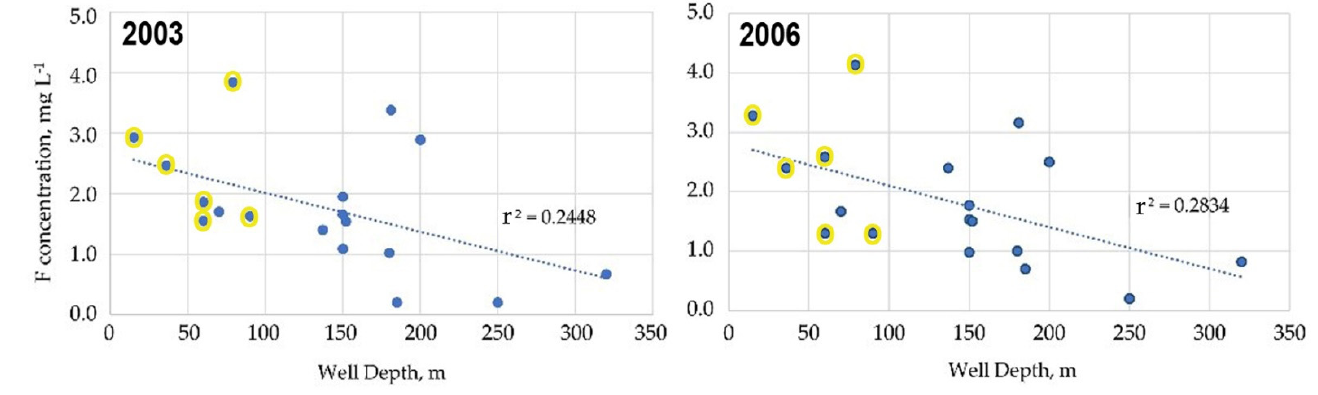
Figure 5. F concentration vs. well depth for 2003 and 2006 data. Points with a yellow rim are located at a discharge area.